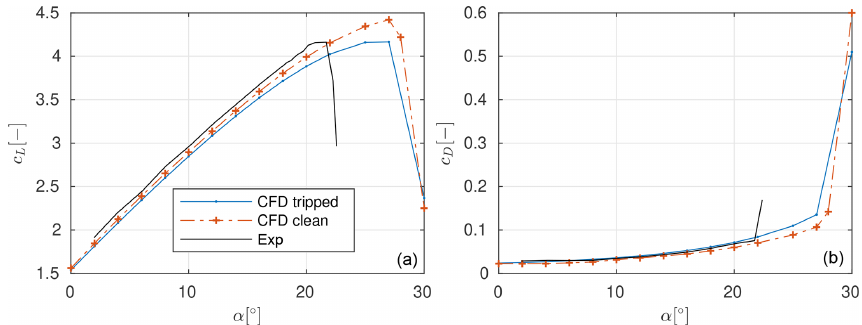
Figure 5. Fluid model validation against the benchmark case from Moir (1993) for (a) the lift polar and (b) the drag polar.